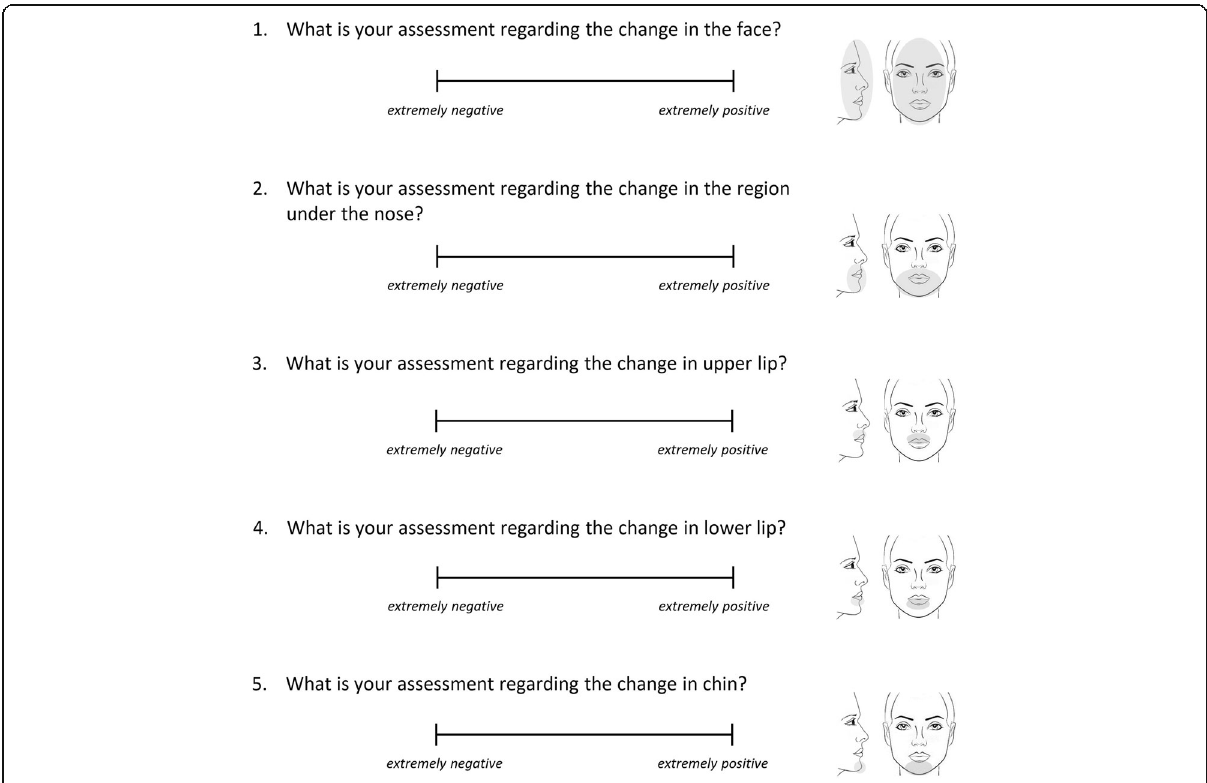
Fig. 2 The questionnaire provided to the raters. “ Extremely negative ” corresponds to 0 and “ extremely positive ” corresponds to 100 VAS